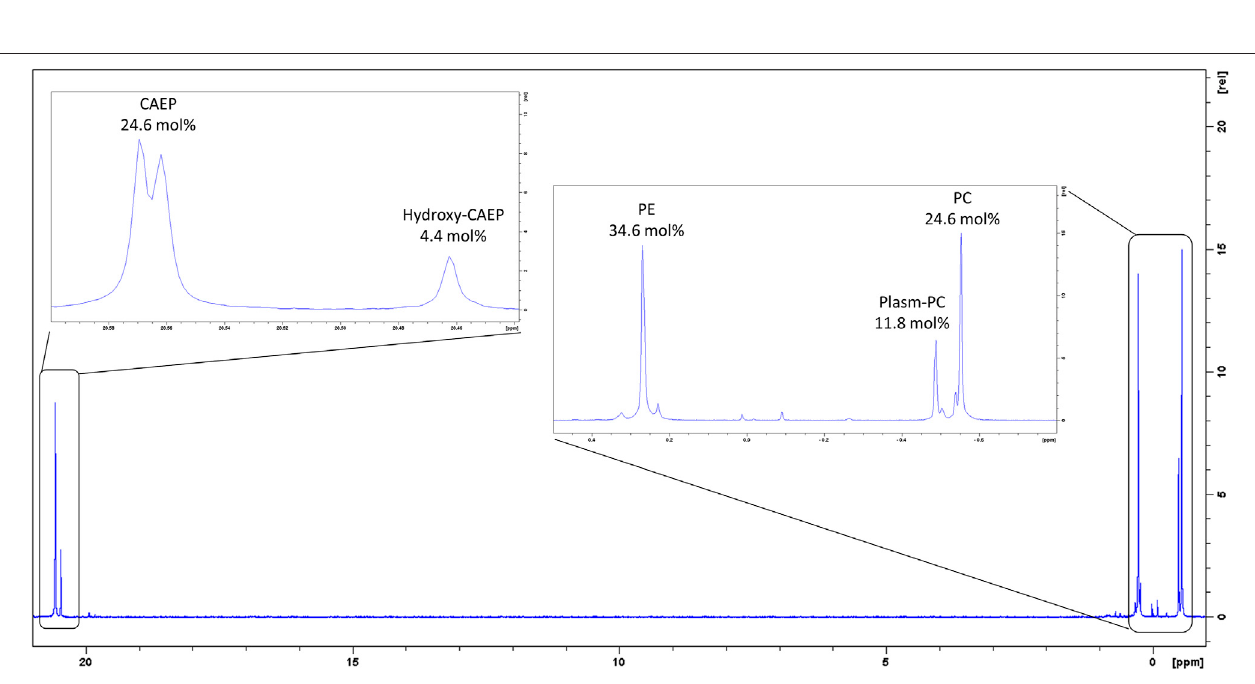
Frontiers in Molecular Biosciences |